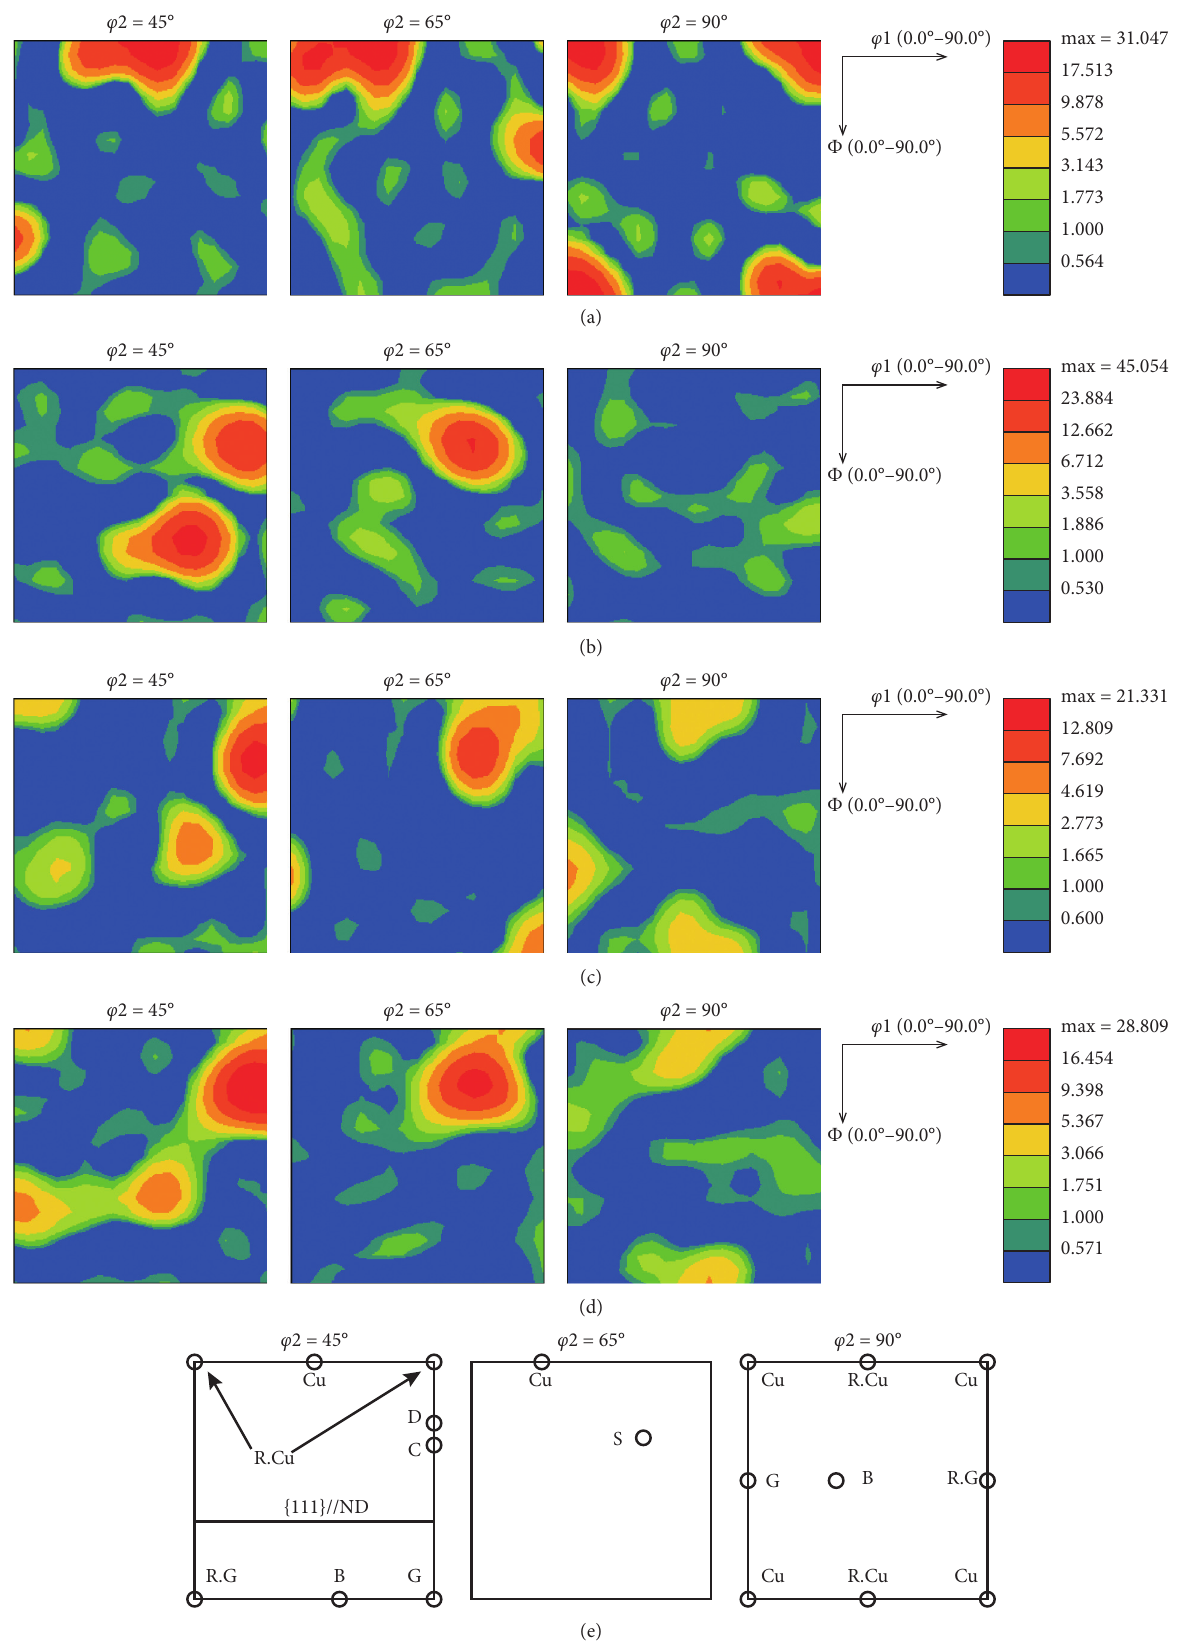
Figure 9: The ODFs of Al in the Al-Nb/Ti/Ni composites: (a) 1st pass, (b) 2nd pass, (c) 3rd pass, (d) 4th pass, and (e) an ideal texture components of Al. Cu: cube; D: dillamore; C: copper; B: brass; G: goss; R.G: rotated goss; R.Cu: rotated cube; S: